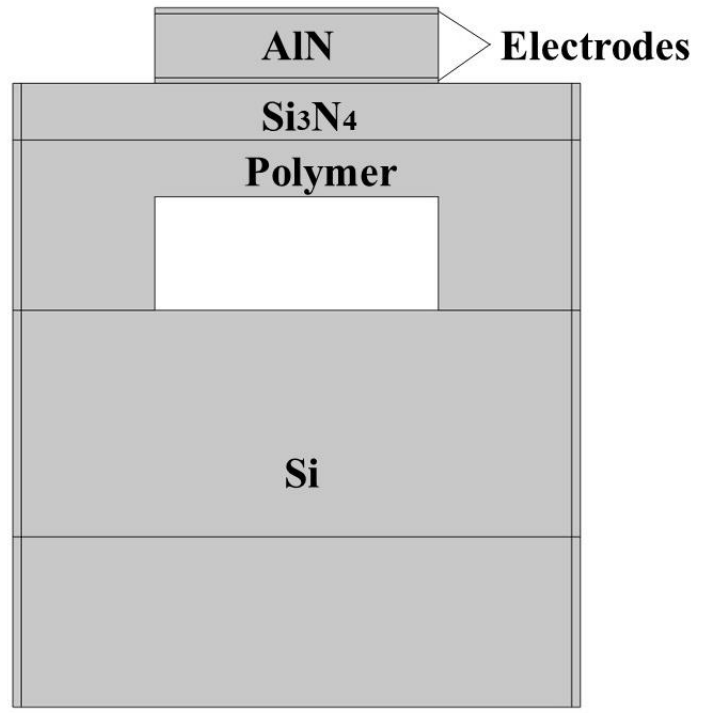
Figure 2. Polymer-FBAR finite element simulation model.